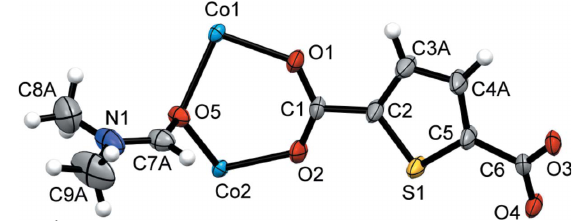
Figure 1 A view of the asymmetric unit of the title compound showing the atom labelling with displacement ellipsoids drawn at the 50% probability